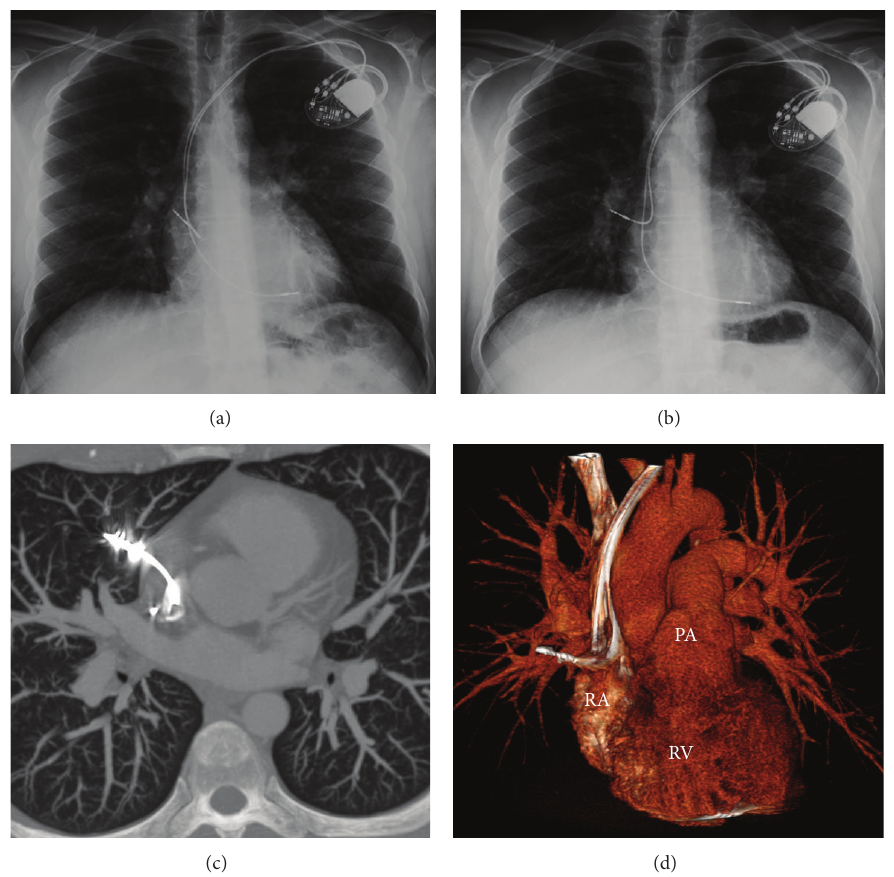
Figure 1: (a) Postimplant anteroposterior chest radiography showing the atrial lead positioned at the basal part of the right atrial appendage. (b) Anteroposterior chest radiography performed at 8 months showing a clear late migration of the atrial lead into the right lung. (c) Contrast- enhanced CT-scanner with maximal intensity projection (MIP) and (d) volume rendered reformatting (anterior view) demonstrating the migration of the atrial lead into the right lung. Notably the pericardium, pleura, and pulmonary parenchyma were normal. RA: right atrium; RV: right ventricle; PA: pulmonary